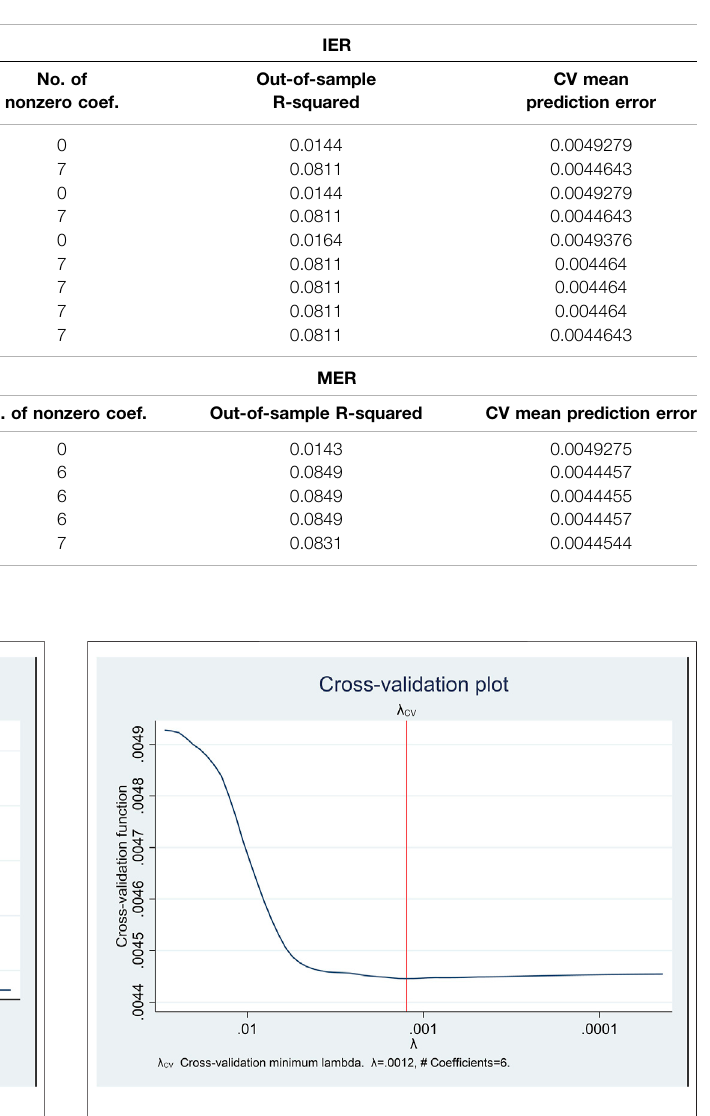
TABLE 4 | Optimal λ value selection of elastic net regression.